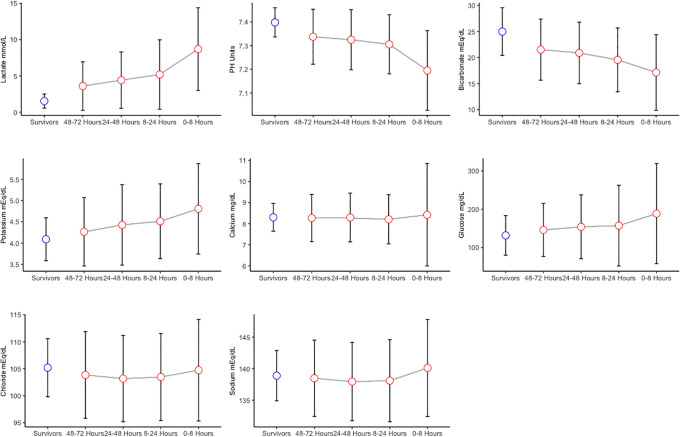
Mean (standard error) parameter values; blue dots represent the survivors, and red dots represent the nonsurvivors.The gray line shows the trend of the laboratory test results during the last 72 hours of life in nonsurviving ICU patients.